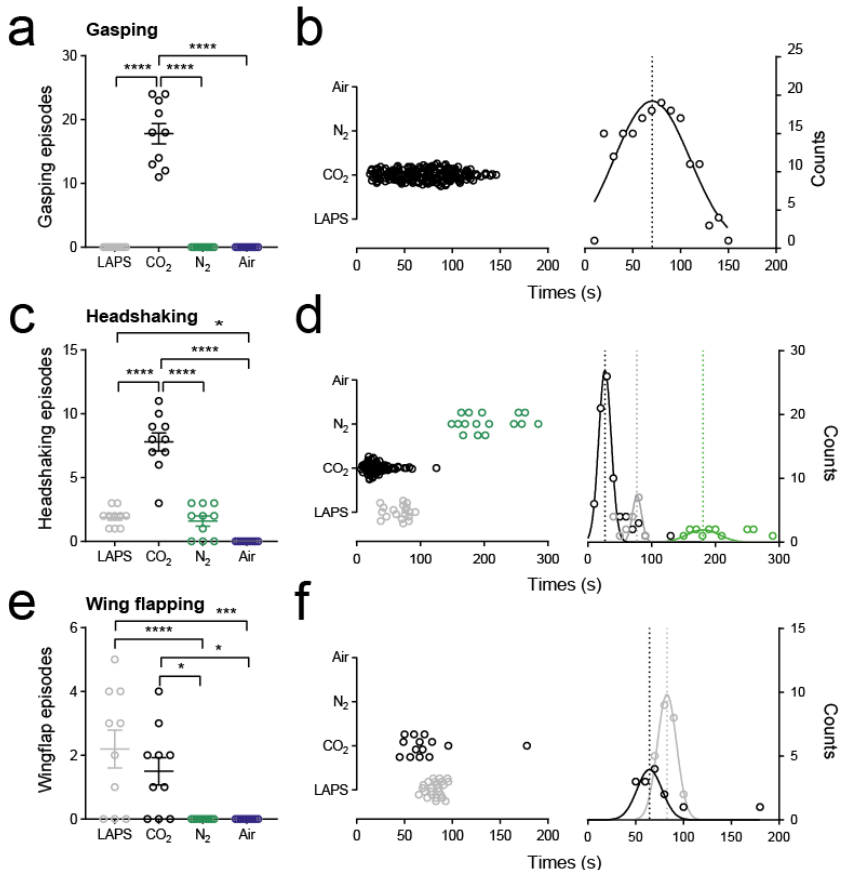
Figure 4. Incidence and timing of aversion behaviours. ( a ). Raw data, mean ± standard error mean (s.e.m.), of number of gasping episodes per bird categorised by treatment group. **** p < 0.0001; one-way ANOVA. ( b ). Left panel shows a cluster plot of all gasping episodes with respect to time from all animals. Right panel shows frequency occurrence of gasping episodes sorted into 10 s bins. The data are fit with Gaussian curves. The asymptote marks the mean of the distribution. ( c ). Raw data, mean ± s.e.m., of number of headshaking episodes per bird categorised by treatment group. * p < 0.05, **** p < 0.0001; one-way ANOVA. ( d ). Left panel shows a cluster plot of all headshaking episodes with respect to time from all animals. Right panel shows frequency occurrence of headshaking episodes sorted into 10 s bins. The data are fit with Gaussian curves. Asymptotes marking the means of the distributions for each treatment group are also shown. ( e ). Raw data, mean ± s.e.m., of number of wing-flapping episodes prior to LOP per bird categorised by treatment group. * p < 0.05, *** p < 0.001, **** p < 0.0001; one-way ANOVA. ( f ). Left panel shows a cluster plot of all wing-flapping episodes prior to LOP with respect to time from all animals. Right panel shows frequency occurrence of wing-flapping episodes sorted into 10 s bins. The data are fit with Gaussian curves. Asymptotes marking the means of the distributions for each treatment group are also shown.